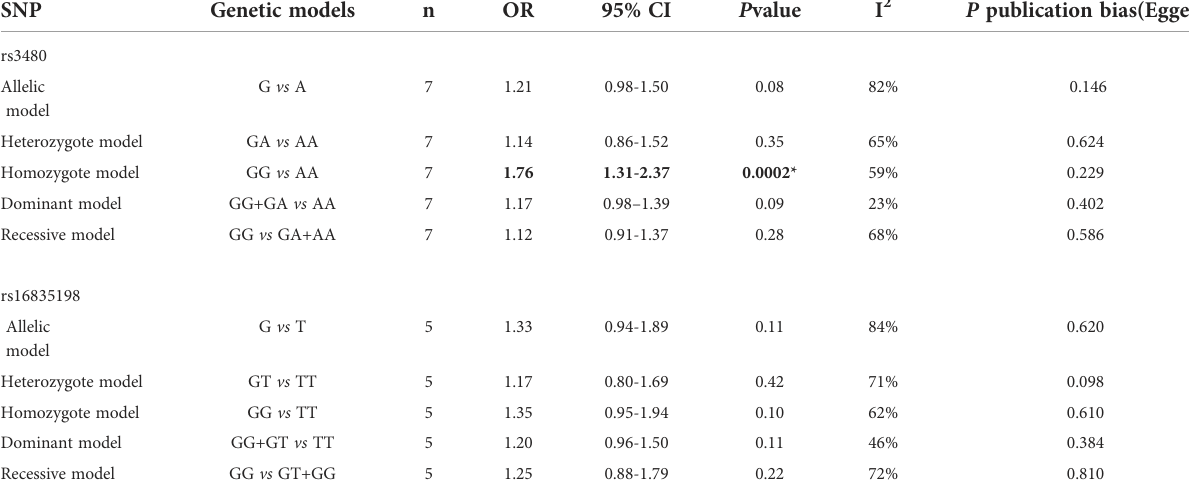
Bold values represents signi fi cant